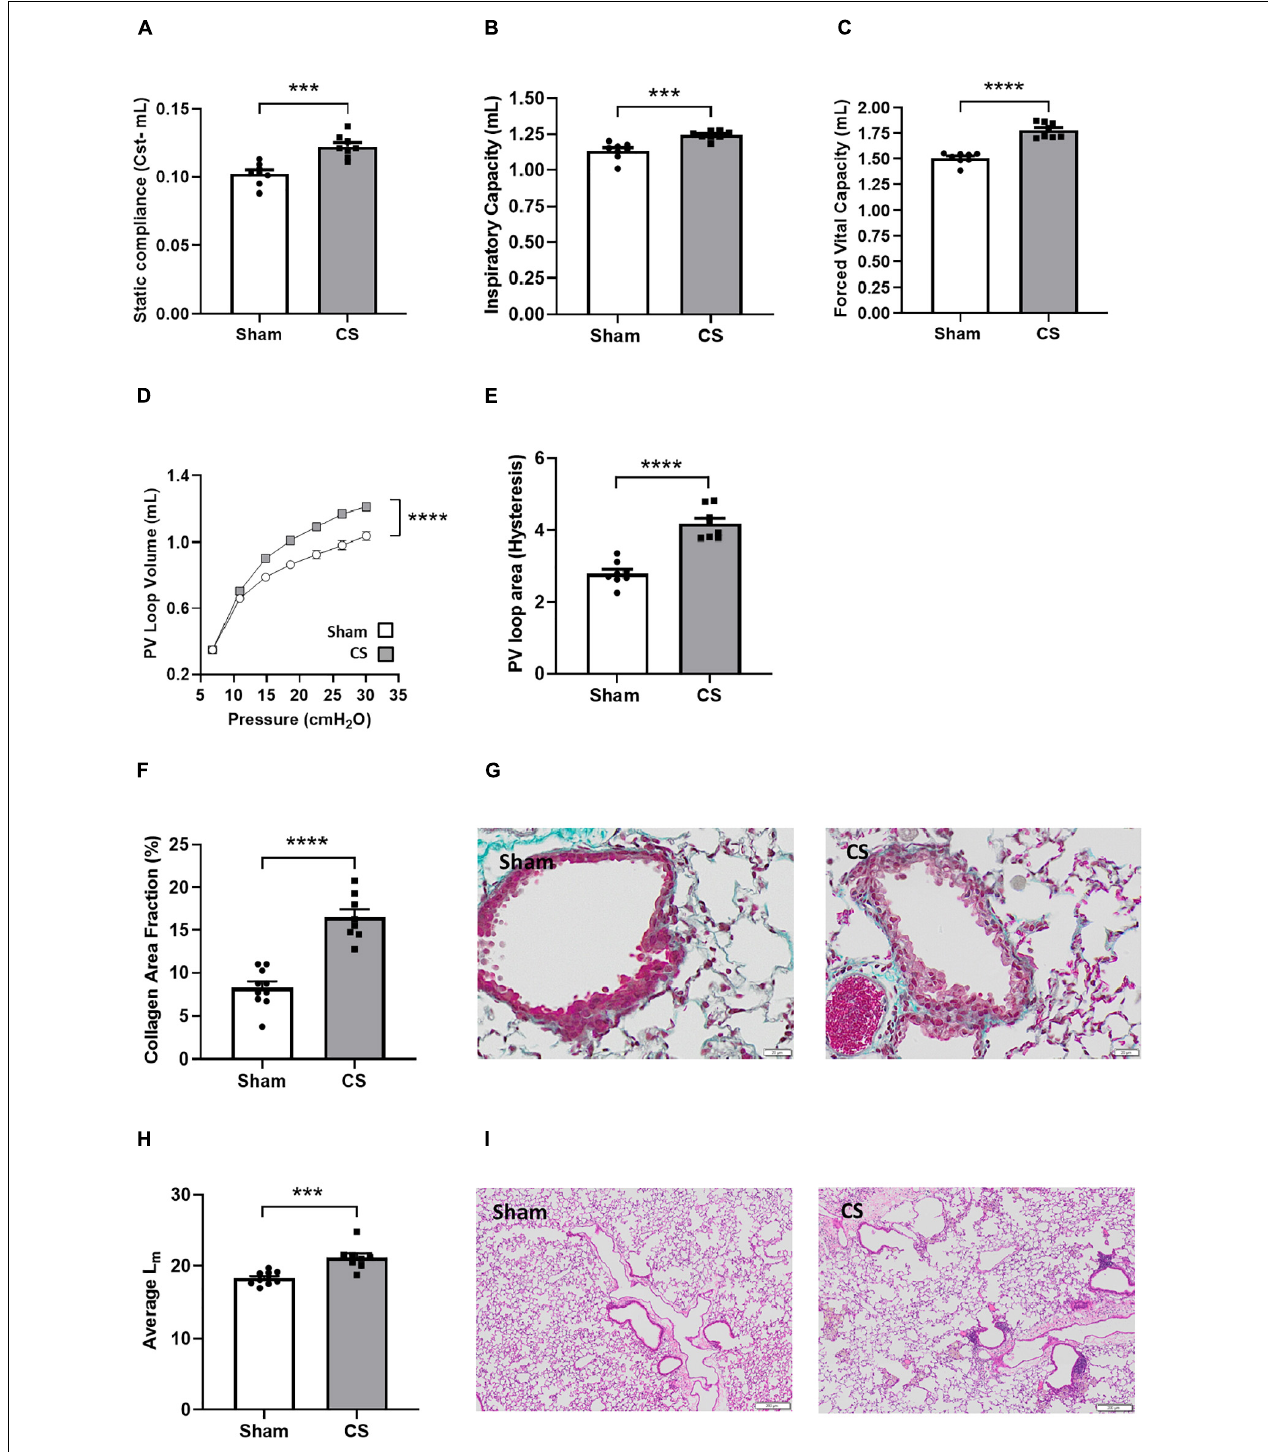
FIGURE 2 | Chronic CS exposure worsened lung function and pathology. Mice were exposed to sham or CS (9 cigarettes/day, 5 days/week for 24 weeks). Lung function parameters assessed included (A) static compliance (Cst) ( n = 8), (B) inspiratory capacity, (C) forced vital capacity, (D) pressure-volume (PV) loop, and (E) PV loop area. (F) Percentage area fraction of collagen ( n = 8–10) and (G) representative images of collagen-stained (blue) sections. (H) Histological analysis of the mean linear intercept (L m ) ( n = 8–10) and (I) representative images of pressure-inflated lung sections. Data was analyzed by Student’s t -test and expressed as mean + SEM with significance being represented as; *** p < 0.001, **** p < 0.0001. PV loop data was analyzed via repeated measures and expressed as mean ± SEM with significance being represented as; **** p < 0.0001.